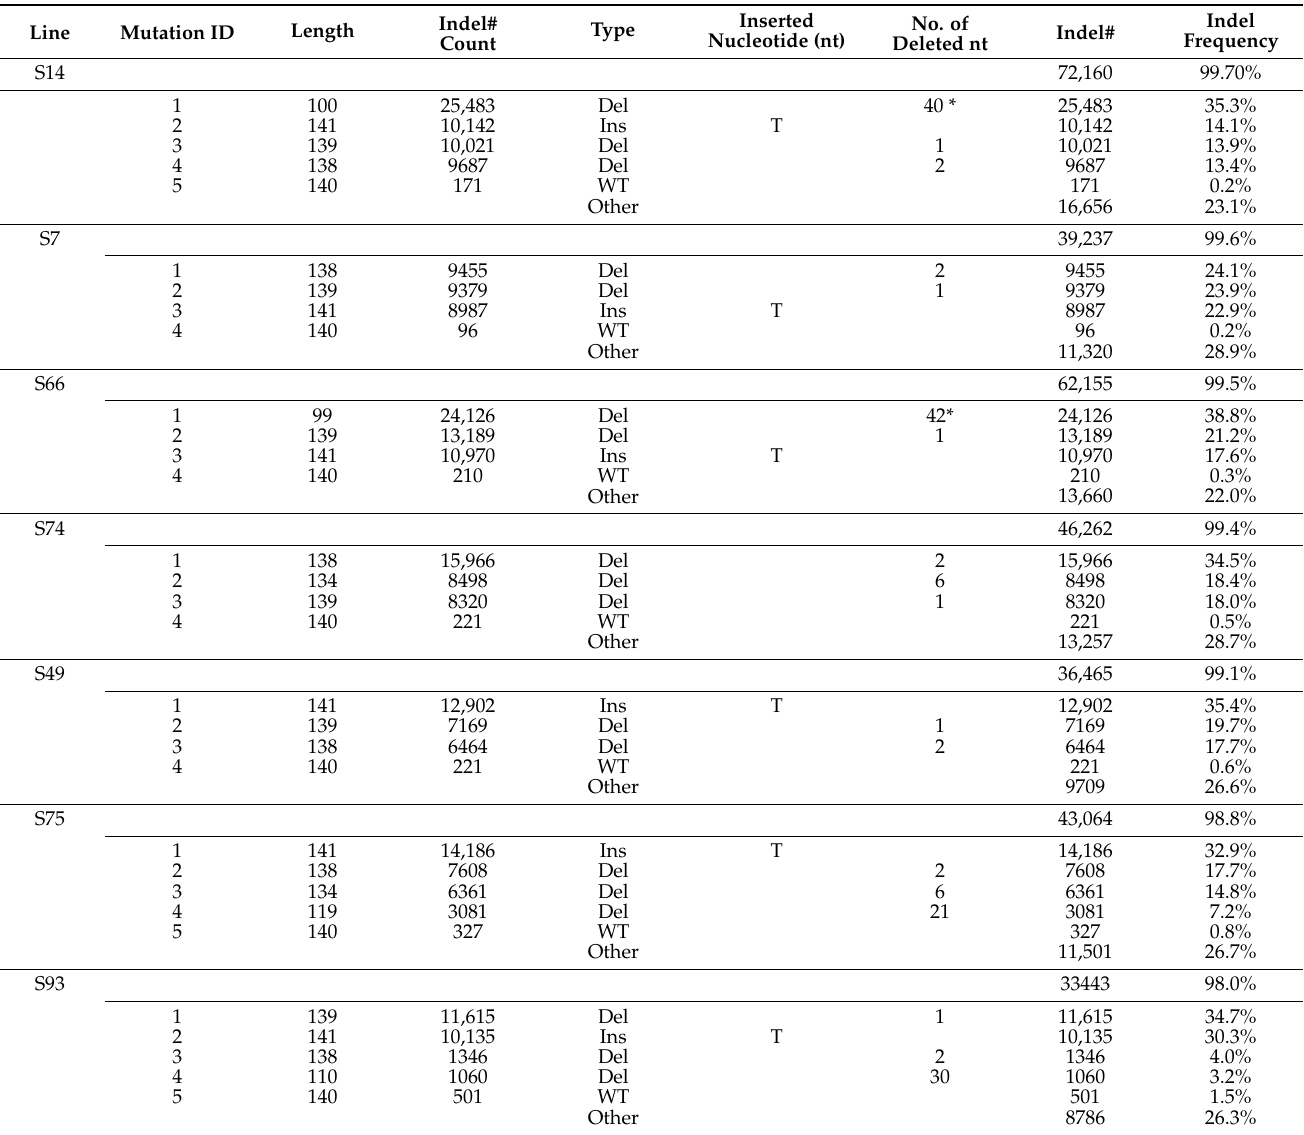
Table 3. Profiles of major mutations in seven T 0 transgenic lines each had an Indel frequency of over 98% for the gRNA2 site. WT: non-edited